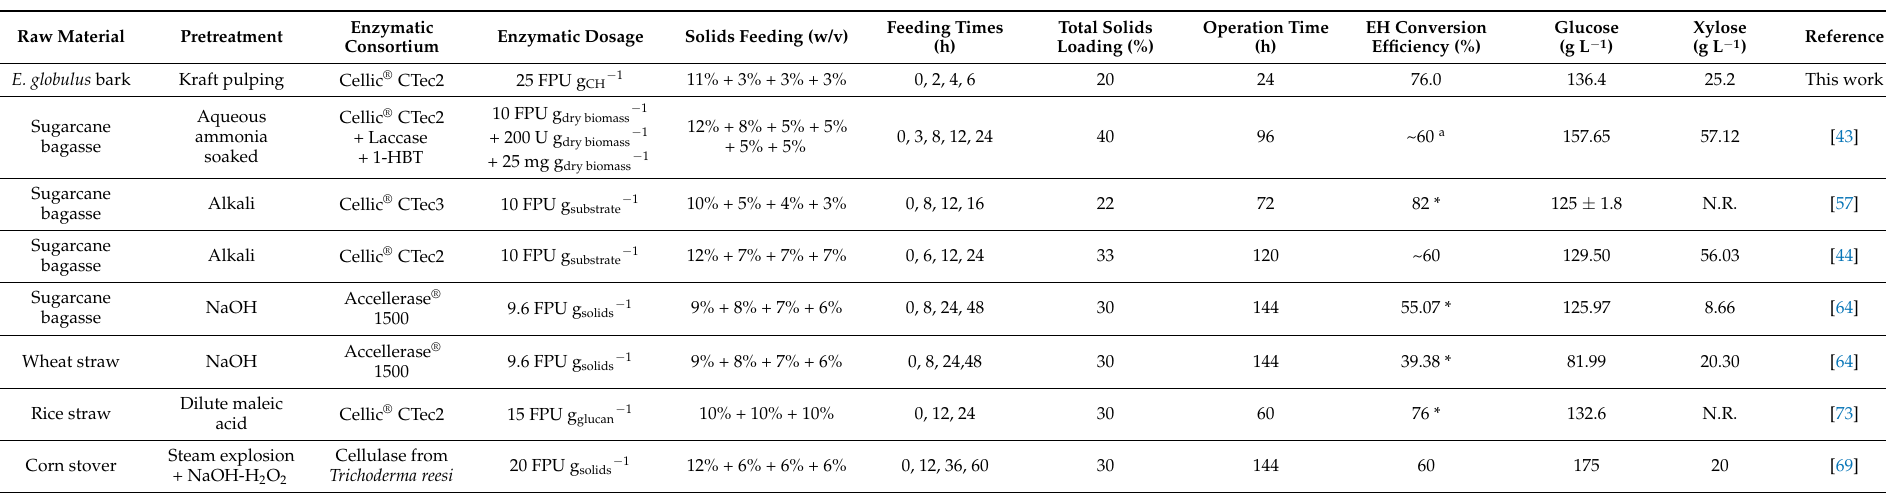
Table 3. Fed-batch enzymatic hydrolysis experiments of lignocellulosic materials at high solids